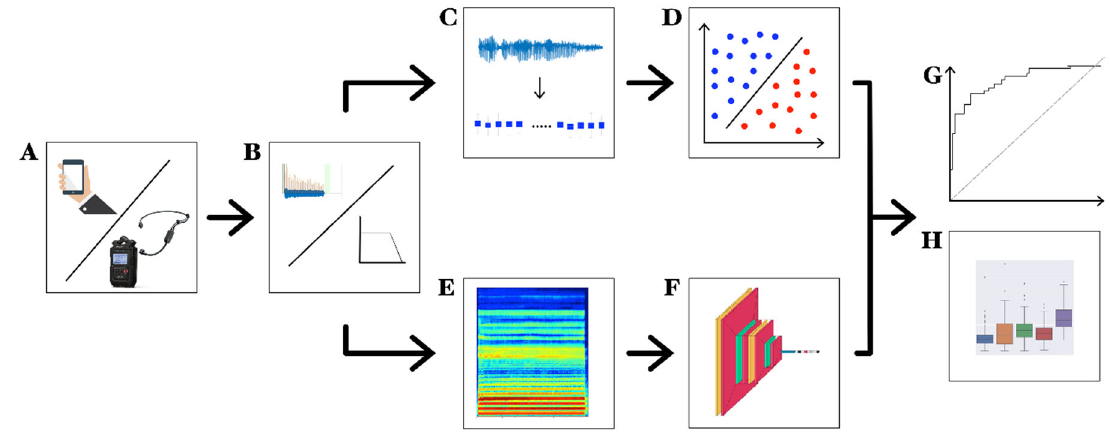
Figure 4. Experimental design (exemplified view): ( A ) recording of voice samples through high-definition audio recorder or smartphone; ( B ) pre-processing; ( C ) feature extraction; ( D ) ML model training (binary SVM shown as an example); ( E ) spectrogram; ( F ) CNN training; ( G ) ROC curves; ( H ) feature distributions.